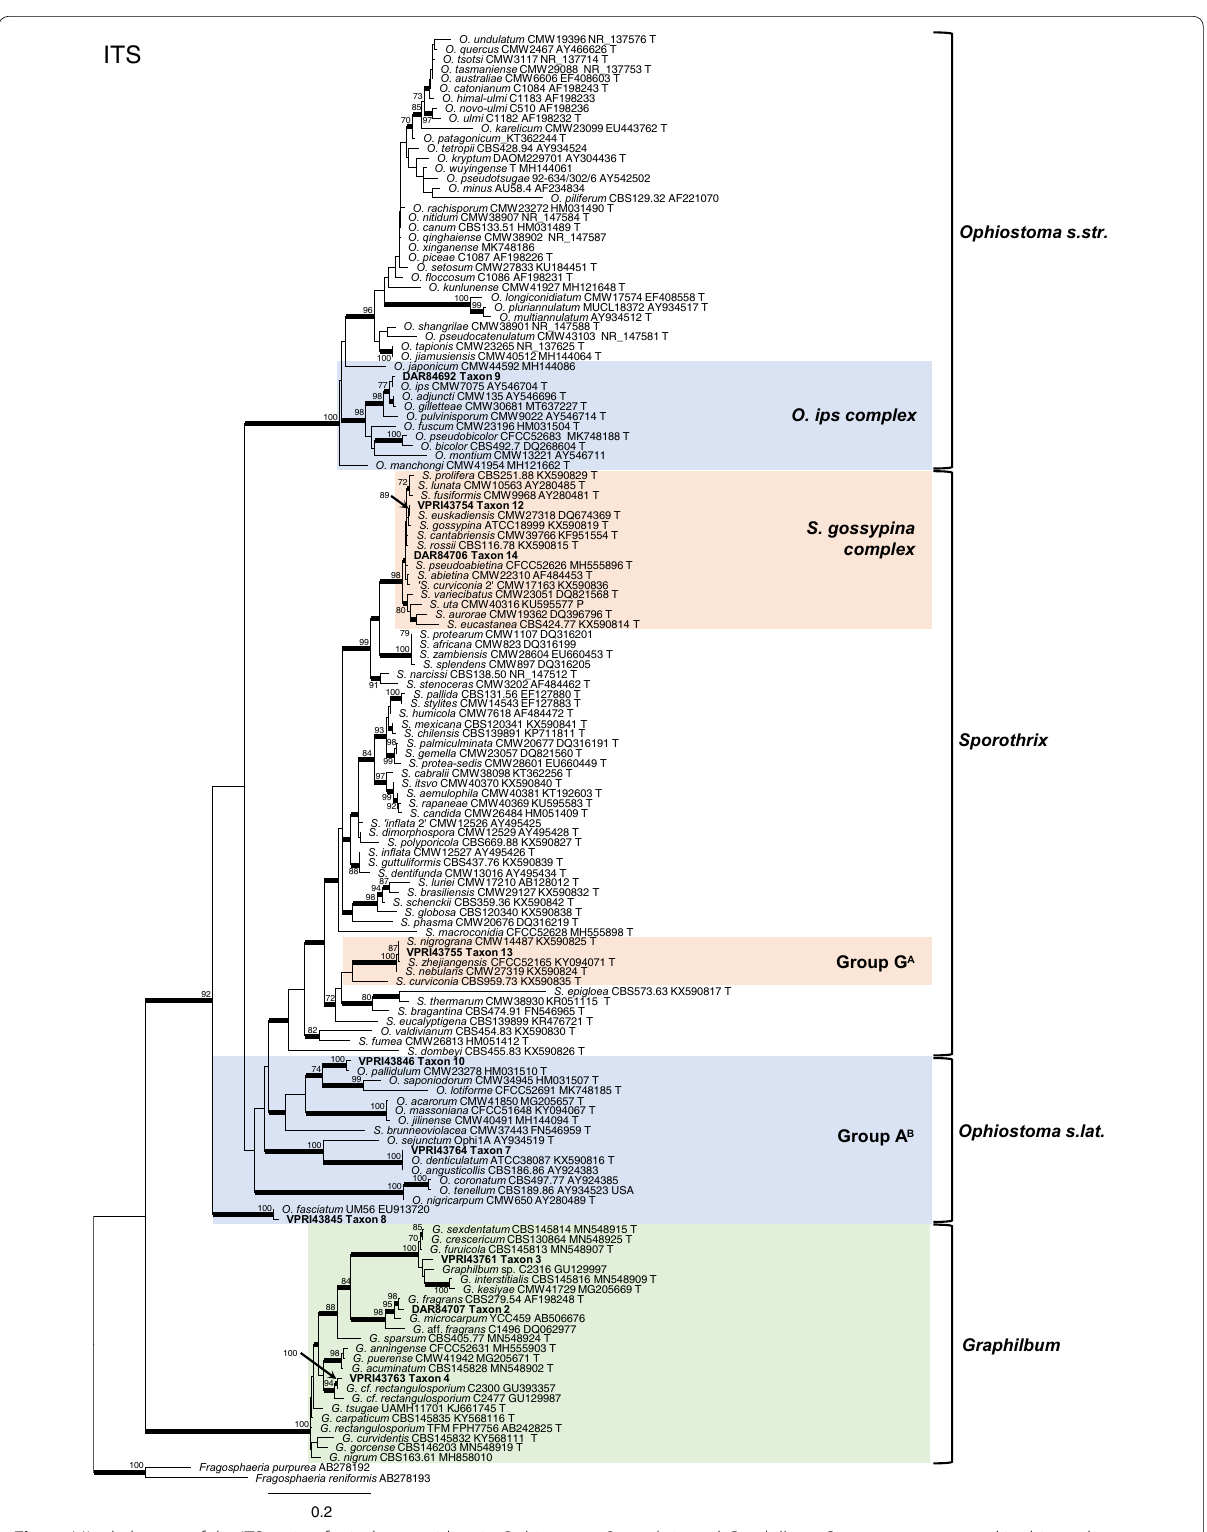
Fig. 1 ML phylogeny of the ITS region for isolates residing in Ophiostoma , Sporothrix . and Graphilbum . Sequences generated in this study are printed in bold. Bold branches indicate posterior probability values cultures. A Group name as described by de Beer et al. (2016). B Group name as described by Chang et al.